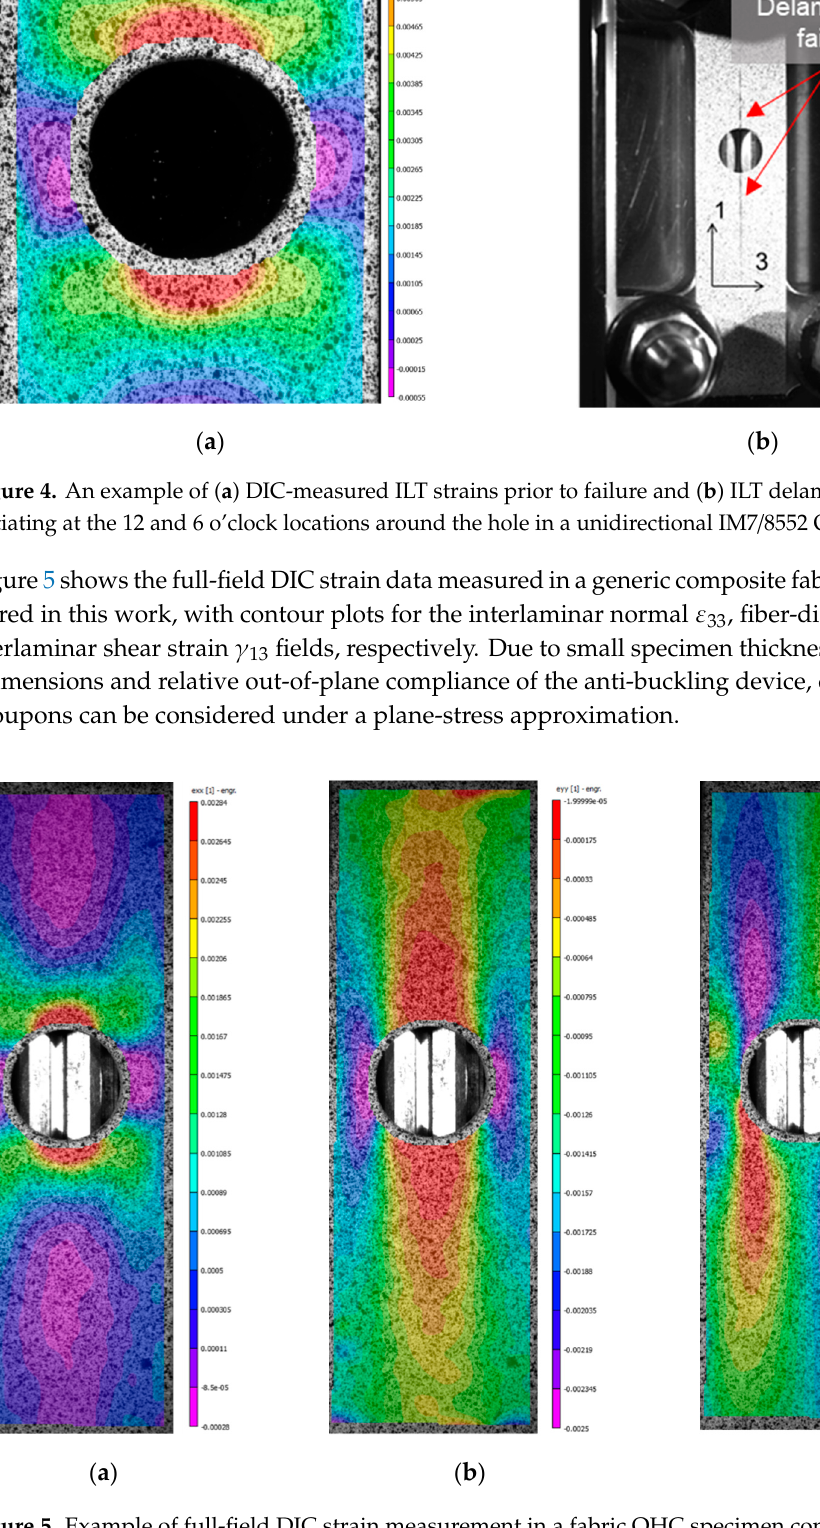
Figure 5. Example of full-field DIC strain measurement in a fabric OHC specimen considered in this work with contour plots of ( a ) transverse through-thickness ε 33 , ( b ) longitudinal fiber-direction ε 11 , and ( c ) interlaminar shear γ 13 strains, respectively.